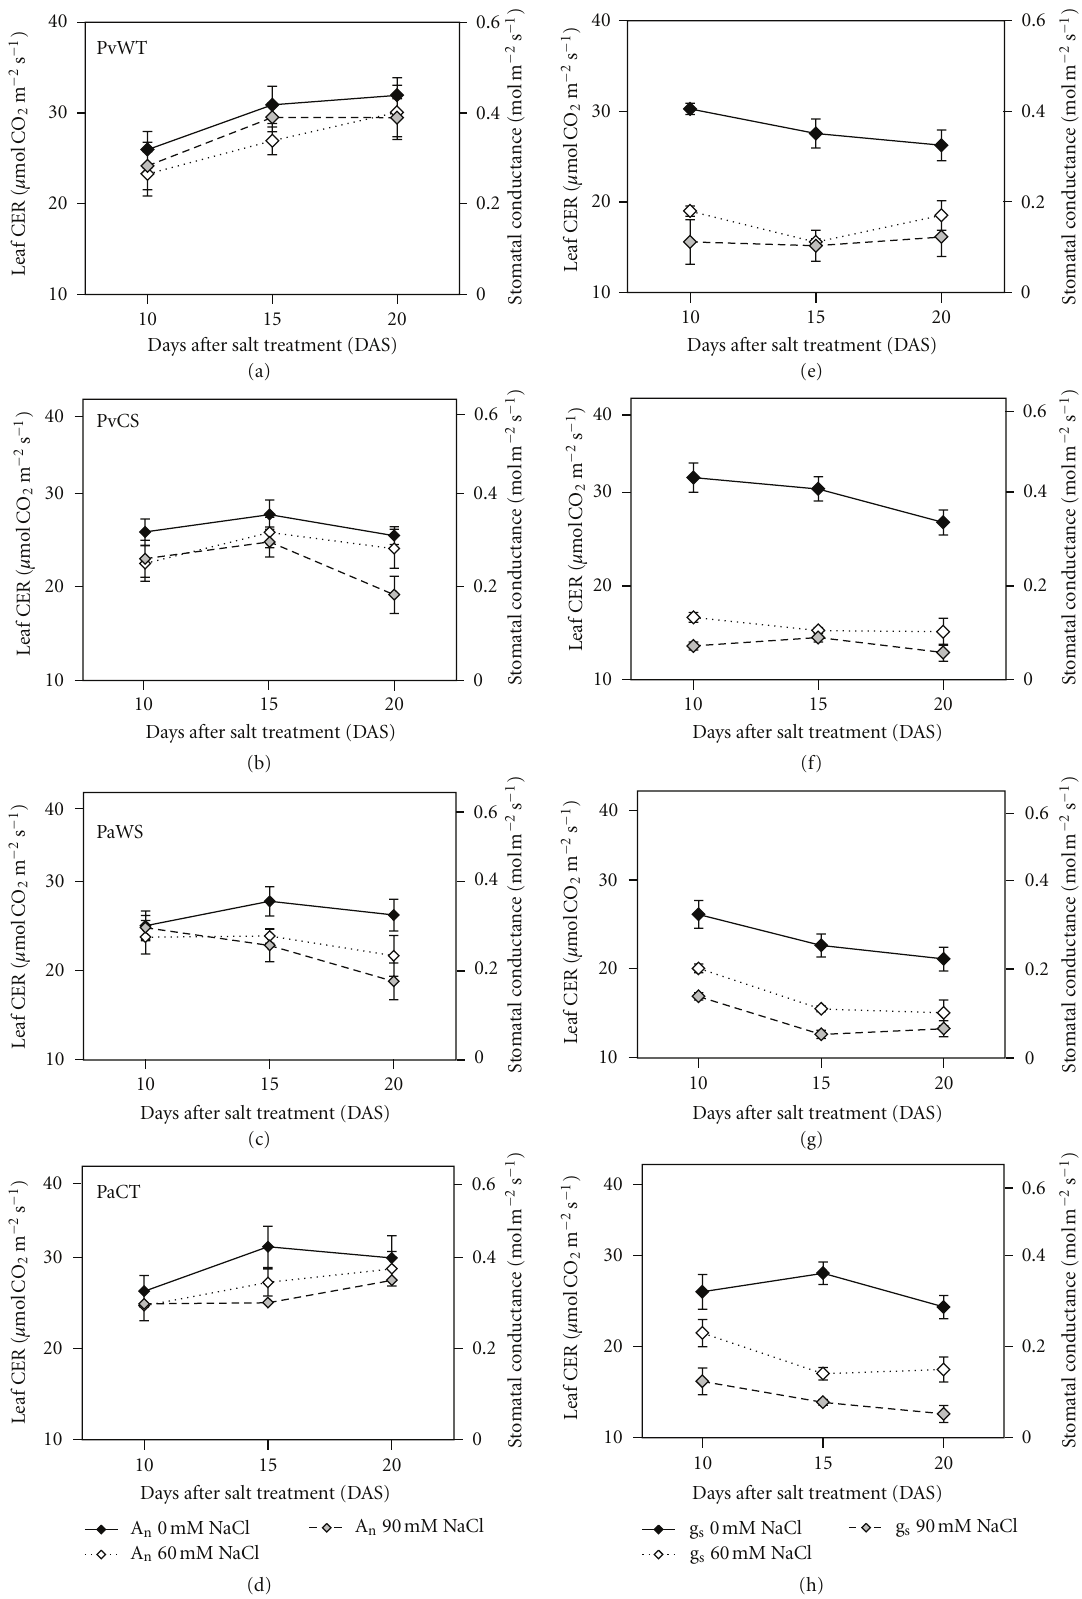
Figure 3: E ff ects of increasing NaCl levels on leaf CO 2 exchange rate ( left axis ; a–d) and stomatal conductance ( right axis ; e–h) between 10 and 20 days of salt treatment for Phaseolus species. Each value represents the mean ± SE of six